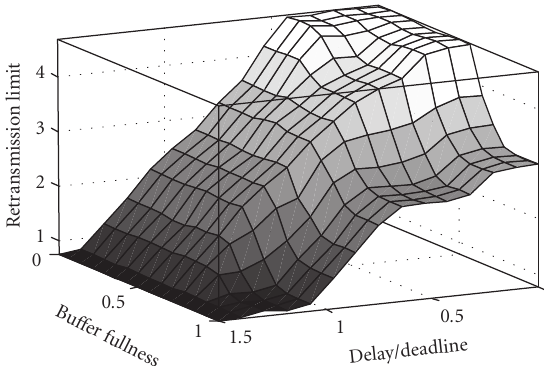
Figure 2: Control surface resulting for FLC